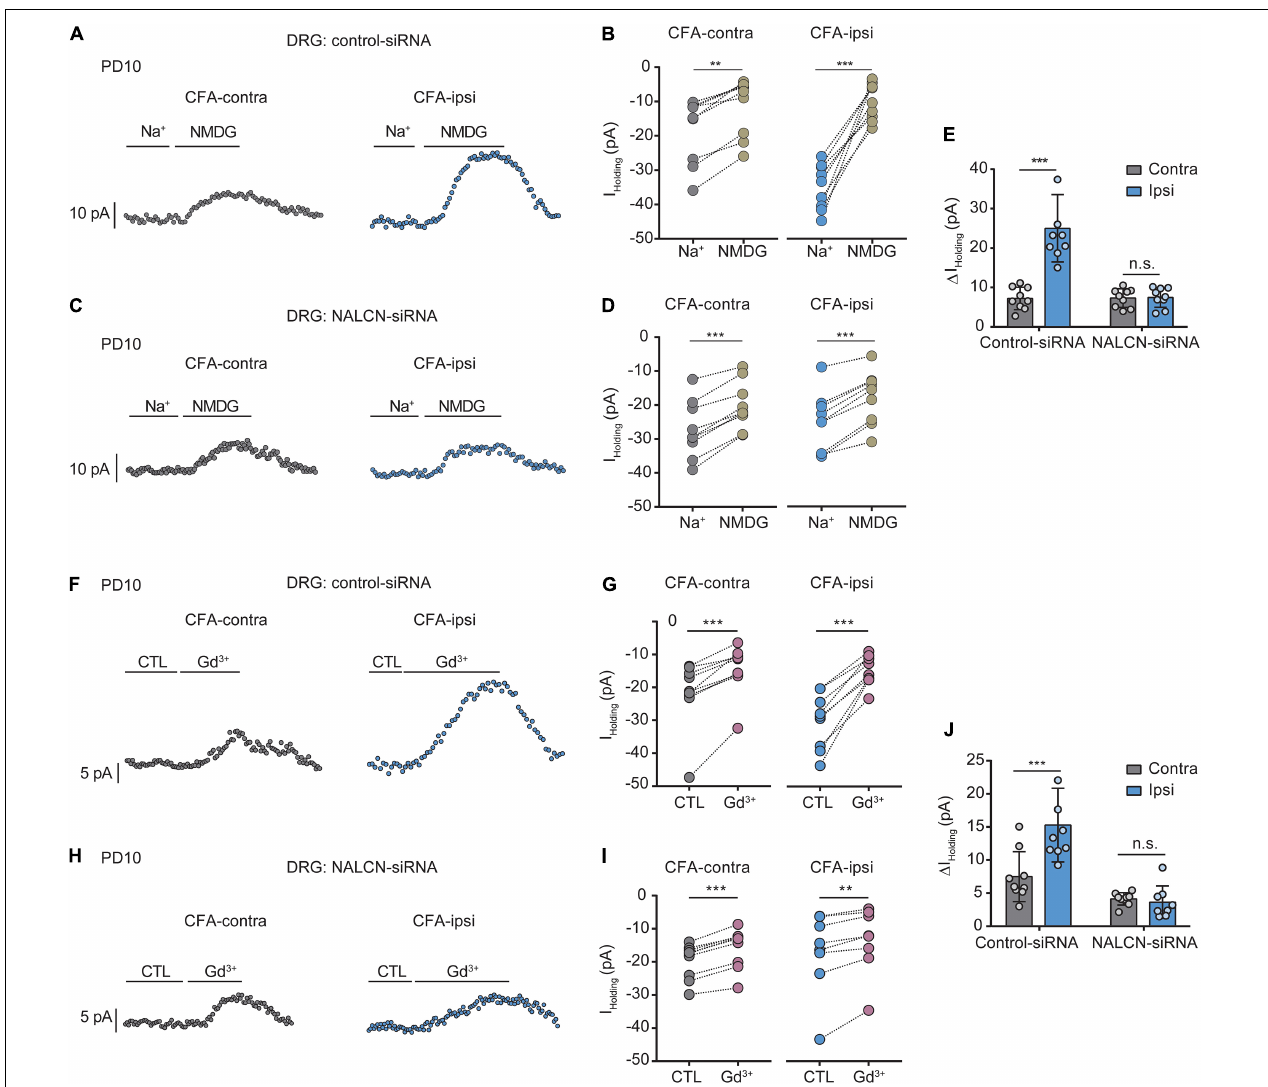
FIGURE 4 | Na + -mediated currents and gadolinium (Gd 3 + )-inhibited holding currents in DRG neurons increase after injection of CFA in neonatal rats. NALCN-siRNA and/or control-siRNA were intrathecally and intraneurally injected into the subarachnoid space and sciatic nerve in P7 rats; CFA was injected 2 days later. (A) Representative real-time analysis of I holding in small and medium neurons from the rats that received control-siRNA combined with injection of CFA. The I holding was recorded at holding potential of –60 mV and extracted by replacing extracellular Na + with NMDG. (B) The I holding in small and medium DRG neurons of control siRNA-treated rats was analyzed before and after replacement with NMDG. (C) Representative real-time analysis of I holding in small and medium neurons from the rats that received NALCN-siRNA combined with an injection of CFA. (D) The I holding in small and medium DRG neurons of NALCN siRNA-treated rats was analyzed before and after replacement with NMDG. (E) The I holding increased more in the DRG neurons of CFA-ipsi side than those of CFA-contra side from the control-siRNA-treated rats; treatment of NALCN-siRNA diminished the difference of I holding between CFA-ipsi and CFA-contra side ( n = 9, by two-way ANOVA, Holm–Sidak test). (F) Representative real-time analysis of Gd 3 + -inhibited I holding in small and medium DRG neurons from the rats that received control-siRNA combined with injection of CFA. (G) The I holding in small and medium DRG neurons of control siRNA-treated rats was analyzed before and after perfusion of Gd 3 + . (H) Representative real-time analysis of Gd 3 + -inhibited I holding in small and medium DRG neurons from the rats that received NALCN-siRNA combined with injection of CFA. (I) The I holding in small and medium DRG neurons of NALCN siRNA-treated rats was analyzed before and after perfusion of Gd 3 + . (J) Gd 3 + -inhibited I holding was increased in DRG neurons of CFA-ipsi side than those of CFA-contra side from control siRNA-treated rats, but no difference was shown between CFA-ipsi side and CFA-contra sides from the NALCN-siRNA-treated rats ( n = 9, by two-way ANOVA, Holm–Sidak test). CFA-contra: CFA-contralateral side; CFA-ipsi: CFA-ipsilateral side; CTL: control, before perfusion of Gd 3 + ; DRG: dorsal root ganglion; RMP: rest membrane potential; AP: action potential. Data are presented as mean ± SD. ** p < 0.01, *** p < 0.001, n.s.: no significance.